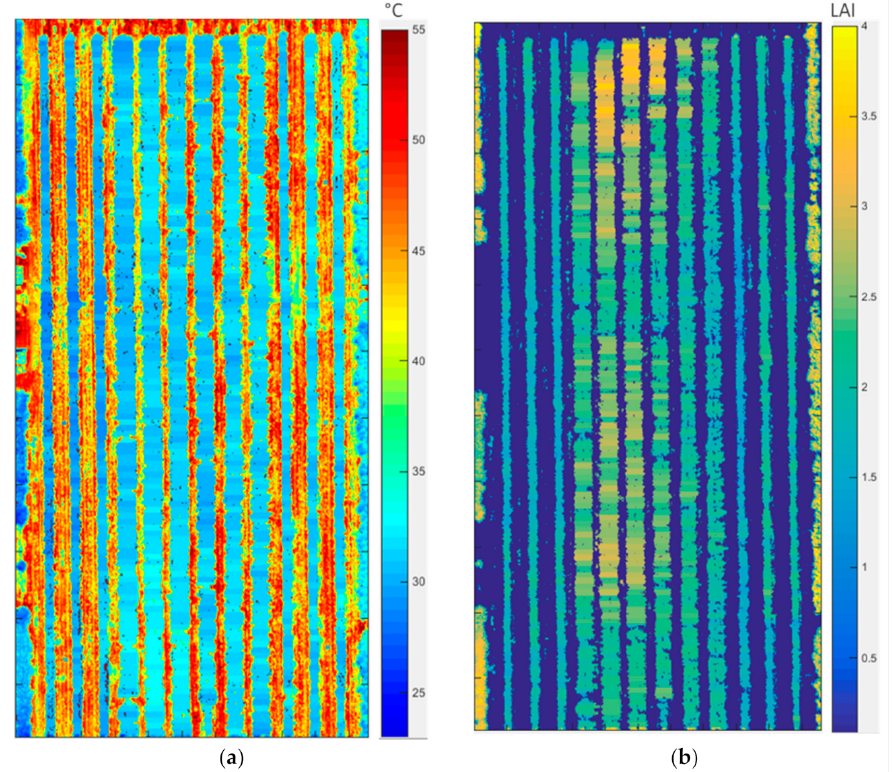
Figure 7. Tree-by-tree segmentation: ( a ) surface temperature map ( ◦ C) and ( b ) LAI map. According to the field descriptions, tree and inter-row spacing are 1.0 m and 4.5 m, respectively. Using the field descriptions and geo-referenced positioning of each row and tree, each tree section was segmented. Then, the mean value of surface temperature and LAI were assigned to each section as a representative tree value. The results provided better analytic maps to feature the individual plants and interpret the variability between plants, enabling the analysis of tree-by-tree water